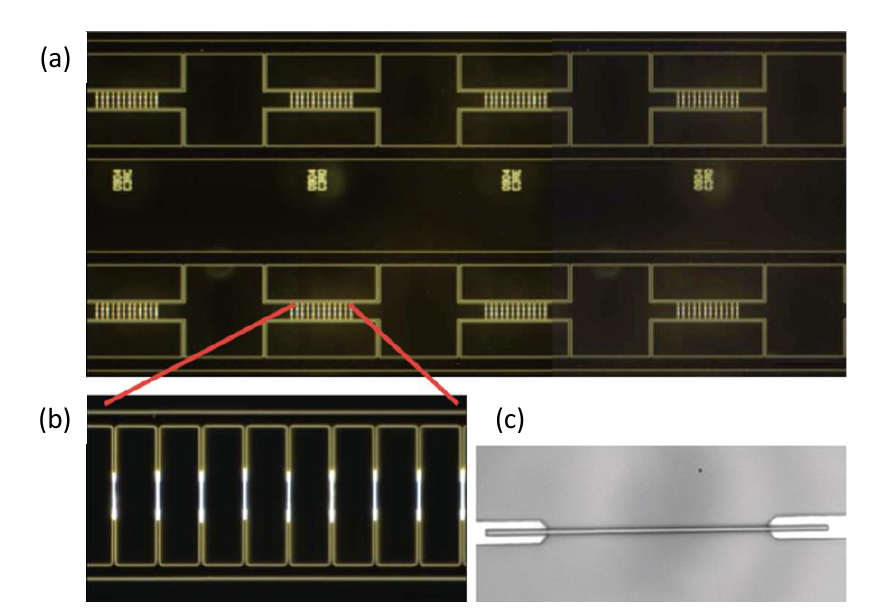
Figure 7. Optical images of Si nanowires assembled onto electrodes on a 4-inch quartz substrate. ( a ) Dark-field image of defect-free nanowire assembly on eight multi-finger electrode arrays; ( b ) Precision alignment of nanowires on a single, dense array. The electrode gap is 12 µm; ( c ) Nanowire on a single electrode (the gap is 12 µm). Reproduced from